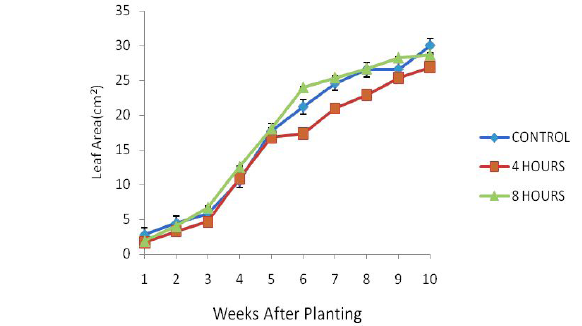
Fig. 2. Effect of prior heat stress on the leaf area of C. papaya